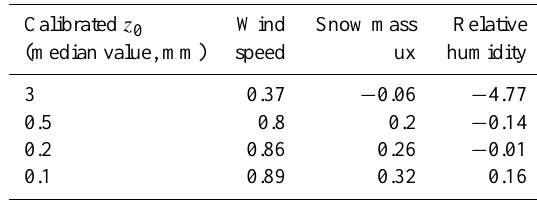
Table 2. Comparison of Nash tests for wind speed, aeolian snow mass flux, and relative humidity at D47 for various median values of z 0